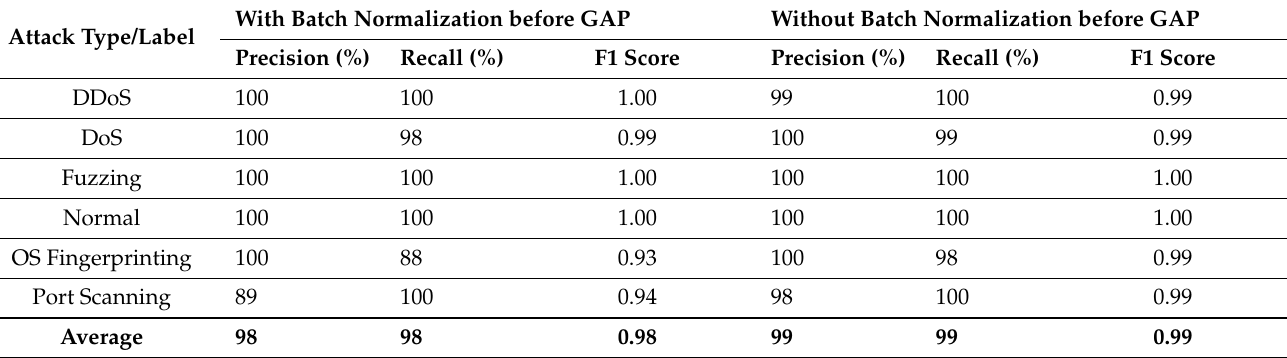
Table 3. The 3 × 3 with and withoutbatch normalization before the global average